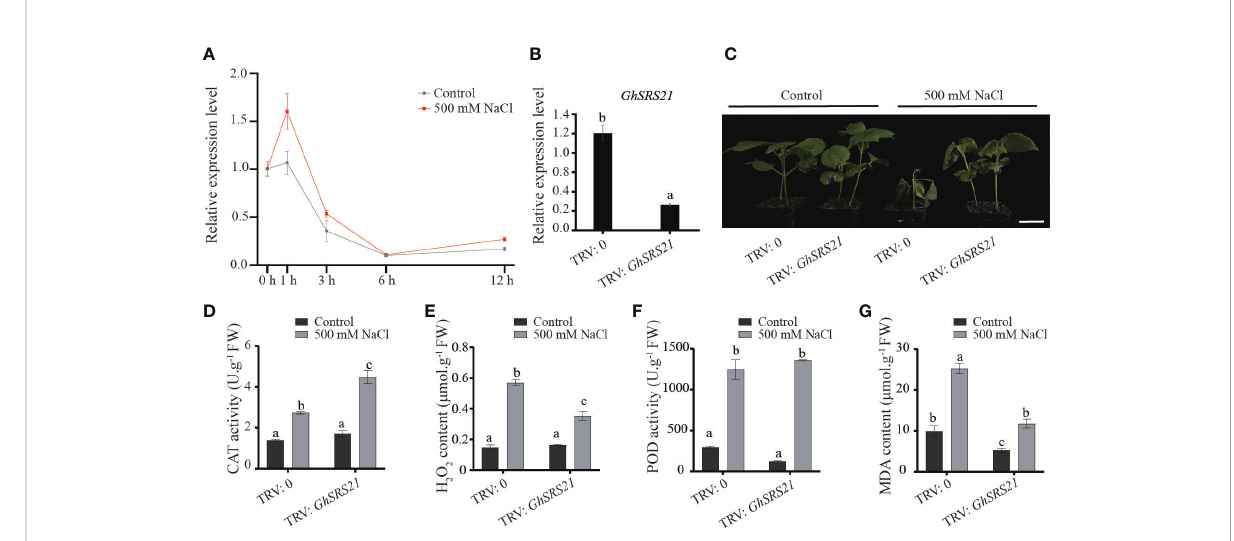
FIGURE 7 Phenotypic identi fi cation of GhSRS21 VIGS line under salt stress. (A) The expression levels of GhSRS21 in the negative control and GhSRS21 VIGS lines under control and 500 mM NaCl at 0 h, 1 h, 3 h, 6 h, 12 h. (B) The expression levels of GhSRS21 in the negative control and GhSRS21 VIGS lines. Each qPCR reaction was performed with three technical replicates. (C) Phenotypic identi fi cation of GhSRS21 VIGS line under control and 500 mM NaCl treatment. TRV2: 0 and TRV2: GhSRS21 represent the negative control and GhSRS21 VIGS line, respectively. Bar = 4 cm (D – G) SOD activity, POD activity and H 2 O 2 , MDA content in the negative control and GhSRS21 VIGS lines under control and 500 mM NaCl treatment. FW indicates fresh weight. Signi fi cant differences are determined using one-way ANOVA and Ducan ’ s Multiple Range Test, as indicated with different letters at P < 0.05 signi fi cance